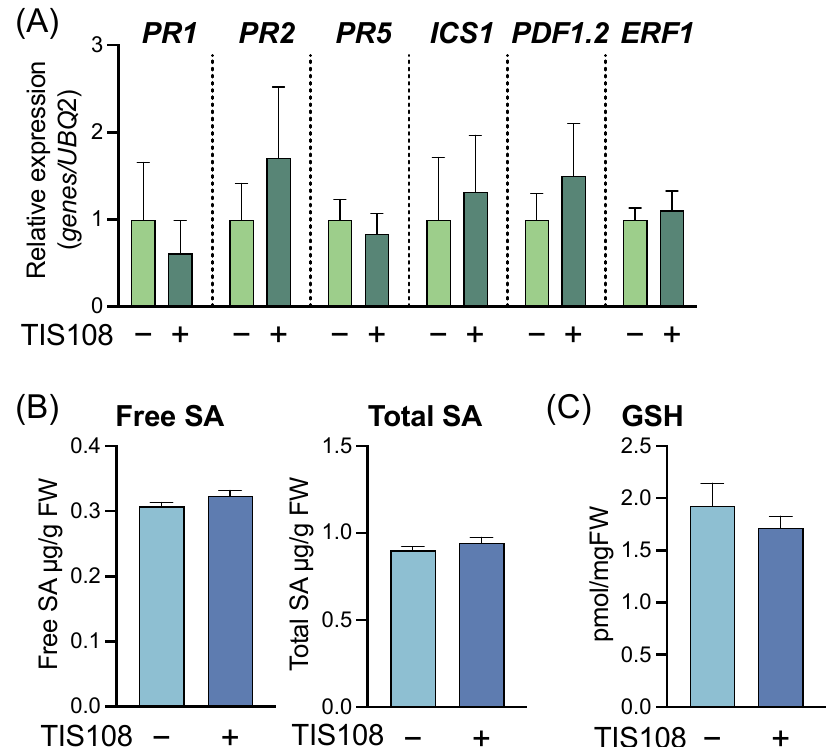
Figure 7. Analysis of defense-related gene expression and metabolite accumulation in Arabidopsis thaliana treated with TIS108. Three-week-old plants were treated with 0,02% dimethyl sulfoxide (DMSO) (–) or 10 µM TIS108 (+) using the soil drenching method, and leaves were collected 3 d after treatment. ( A ) Expression levels of PR1 , PR2 , PR5 , ICS1 , PDF1.2 , and ERF1 in TIS108-treated plants. Transcript levels were normalized using the expression of UBQ2 in the same samples. Relative mRNA levels of each gene among the treatments are presented. Values are means ± SE ( n = 4). ( B , C ) Accumulation of free and total SA and GSH in TIS108-treated plants. The levels of free and total SA (free SA + SA glucoside) and GSH were quantified using high-performance liquid chromatography.